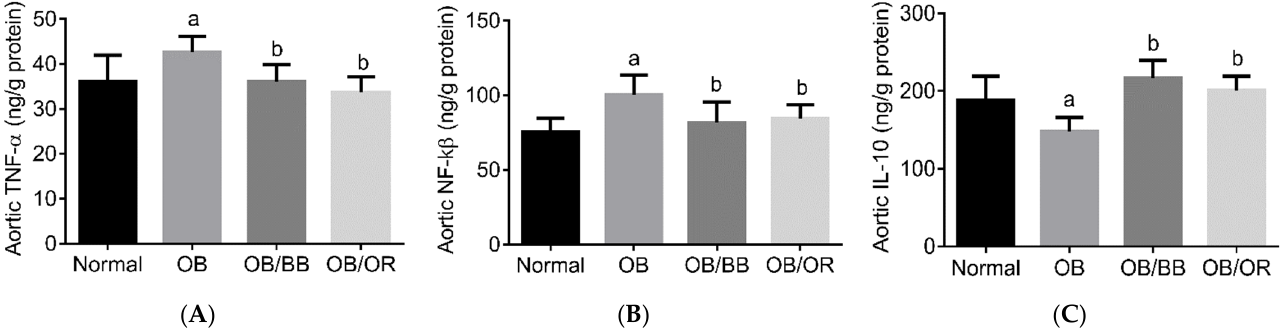
Figure 1. Protein levels of pro- and anti-inflammatory markers ( A ) TNF- α , ( B ) NF-k β and ( C ) IL-10 in the aorta of all experimental groups. All results are expressed as mean and standard deviation, n = 10/group. a p < 0.05 compared to normal group, b p < 0.05 compared to the OB group. All data were analyzed using one-way ANOVA followed by Tukey’s post hoc test. OB: obese, OB/BB: obese and bee bread 0.5 g/kg/day, OB/OR: obese and orlistat 10 mg/kg/day, IL-10: interleukin-10, TNF- α , tumor necrosis factor- alpha , NF-k β : nuclear factor-kappa β .